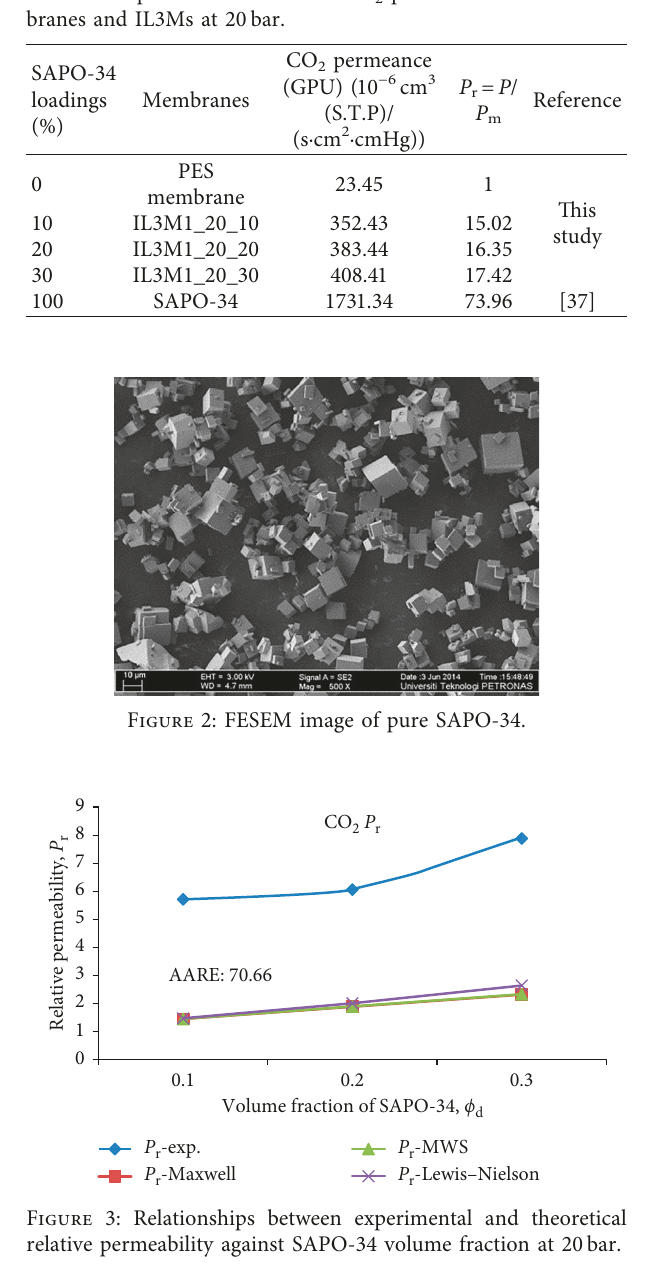
2 permeation of PES mem-